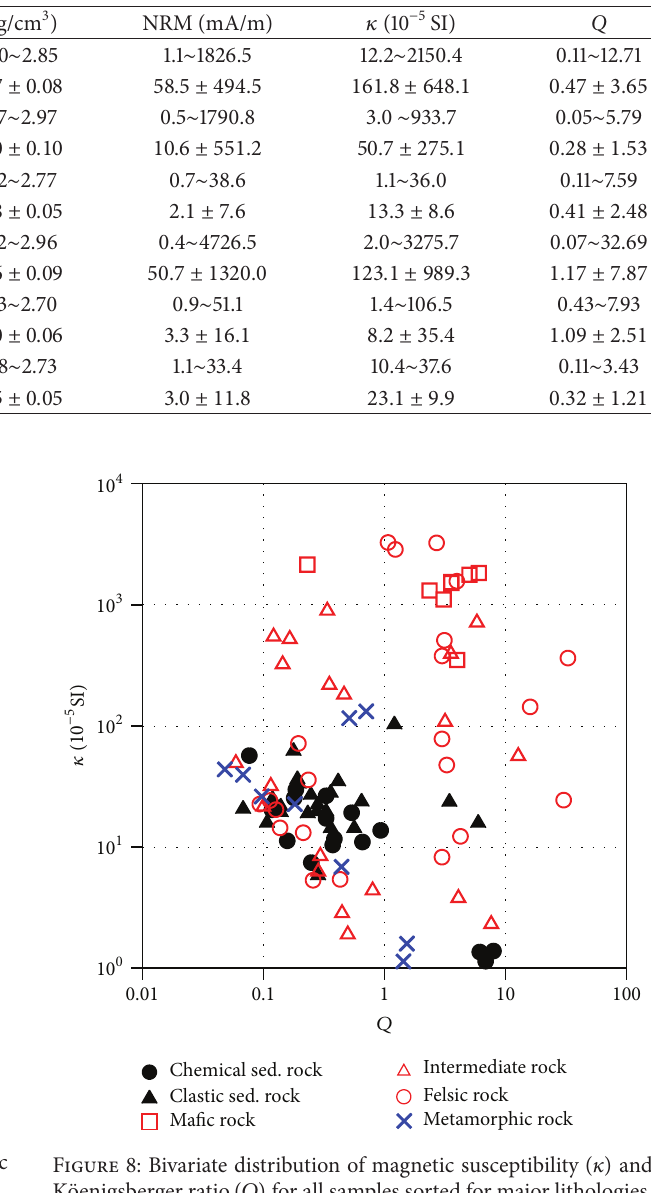
Table 6: Statistical results of 𝜌 , 𝜅 , NRM, and Q values of rocks in different tectonic units.